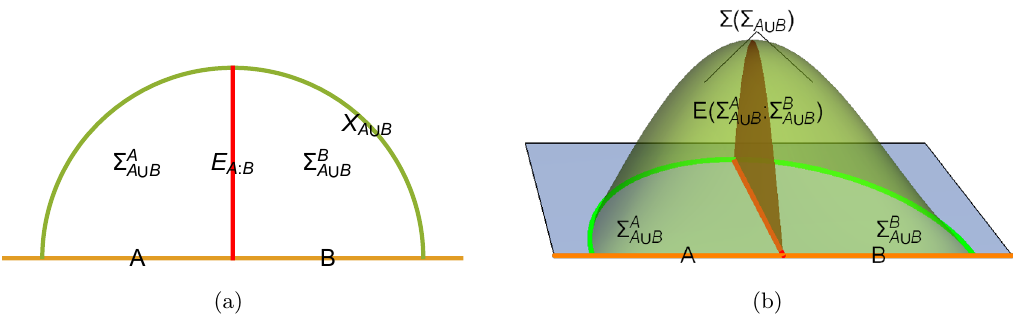
Figure 1 . (a) The cartoon of an EWCS E A : B in the holography of AdS 3 , where a bipartite system with subregion A and B is set on the boundary. (b) The cartoon of the EWCS in double holography, where AdS as a brane (plotted in blue) is embedded into a 4-dimensional spacetime. The reflected 3 (cid:1) . entropy is contributed by two terms, namely the area of E and the area of E (cid:0) Σ A : Σ B A : B A ∪ B A ∪ B where h is the induced metric on the boundary, and Σ the induced metric on P . K is its extrinsic curvature scalar and R is the intrinsic curvature scalar of h . The ϑ and k h are the intrinsic curvature scalar and extrinsic curvature scalar of P . The constant α